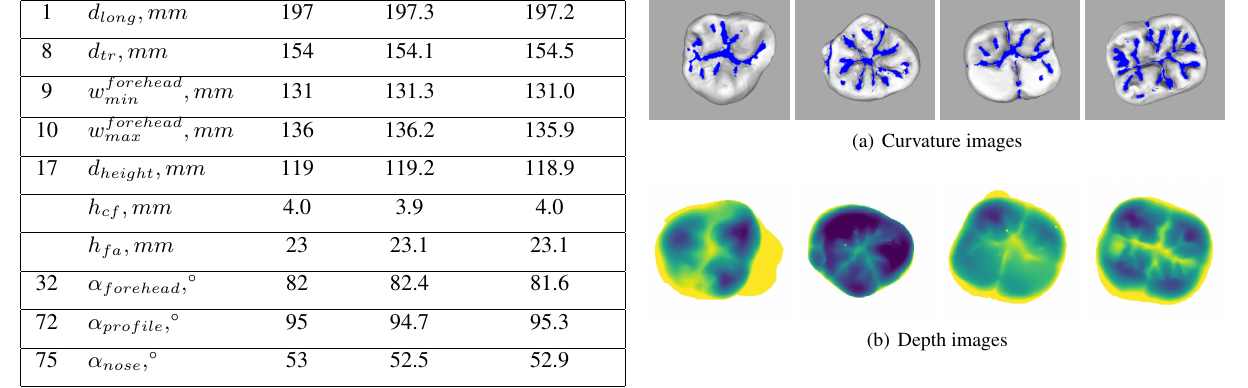
Figure 7. Samples from training